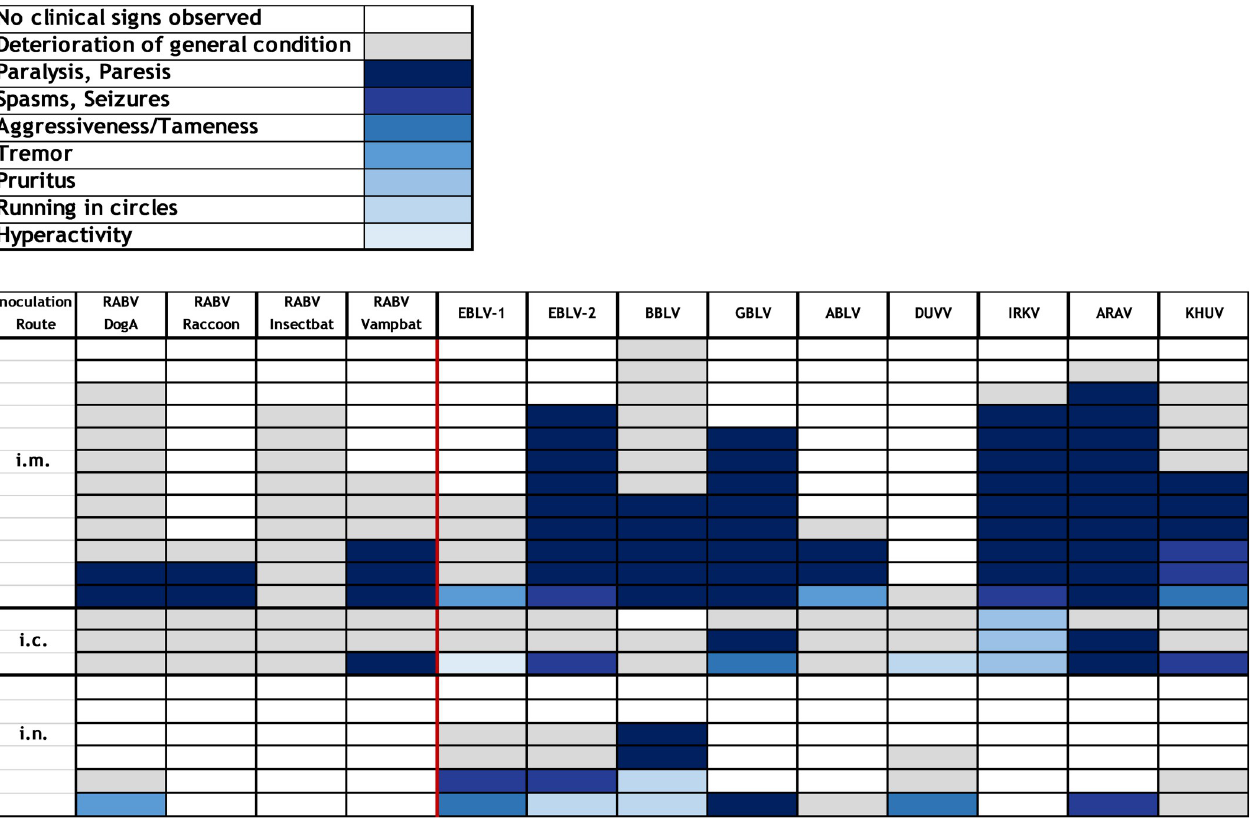
Fig 5. Clinical signs in individual mice inoculated with the indicated lyssaviruses by the i.m. (n = 156; 78 high dose and 78 low dose), i.c. (n = 39) or i.n. (n = 78) route of infection. The color code per cell represents the predominant clinical sign for each individual mouse before euthanasia or death. For clarity, high and low dose i.m. infections were